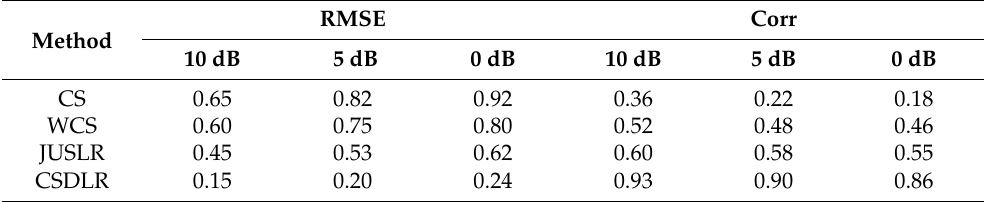
Table 3. Comparison of RMSE and Corr of different imaging methods in measured data experiment. RMSE Corr Method 10 dB 5 dB 0 dB 10 dB 5